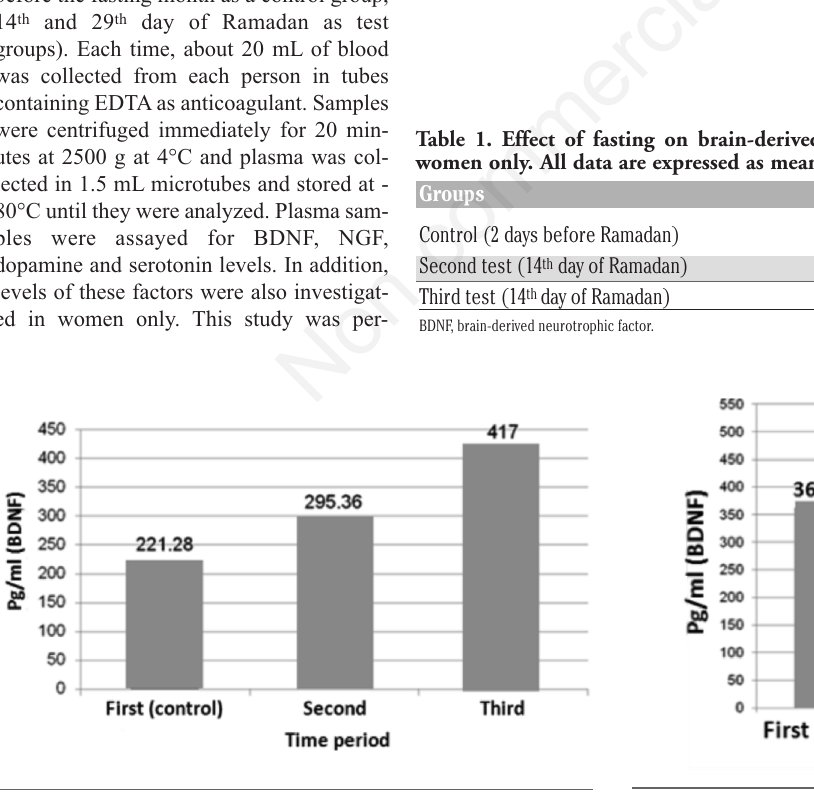
P<0.05.Figure 1. Effect of fasting on brain-derived neurotrophic factor levels on 14 th (second) and 29 th (third) day of Ramadan com- pared to the control group. All data are expressed as mean±stan- dard error of mean;